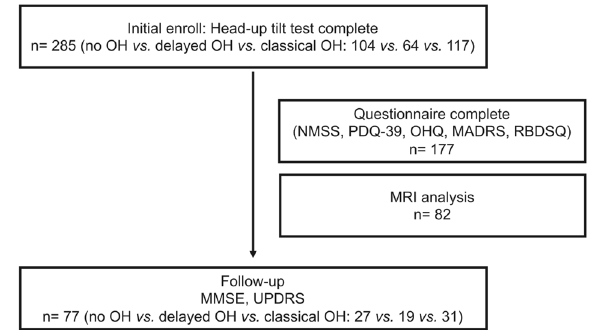
Fig. 1 Enrolled patients study fl ow. NMSS Non-Motor Symptoms Scale, PDQ-39 Parkinson ’ s Disease Quality of Life-39, OHQ Orthostatic